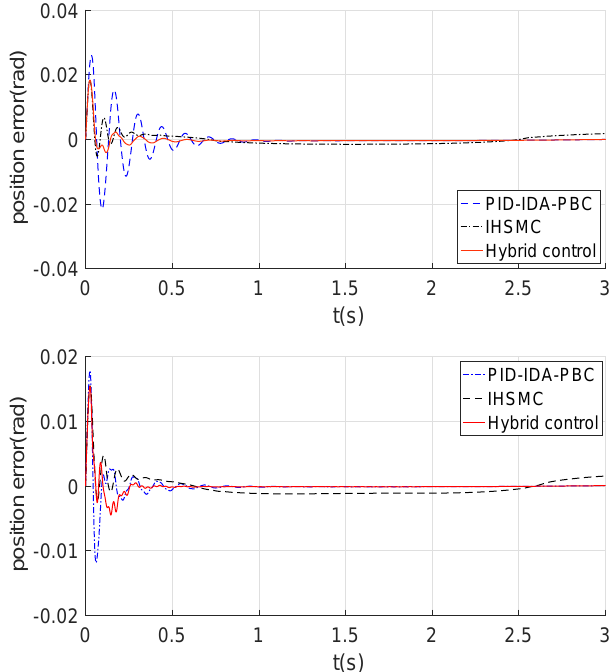
Figure 7. Curves with different control algorithm of each joint.